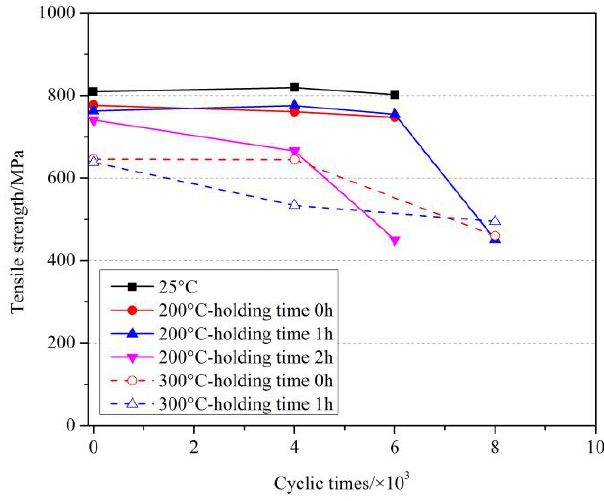
Figure 10. The effect of cyclic load on the tensile strength of GFRP bars at 200 and 300 °C.